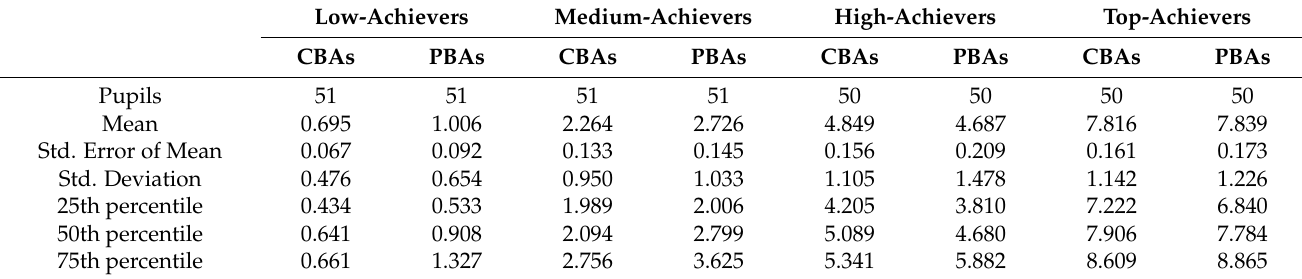
Table 6. Descriptive PRSs statistics of subgroups of achievers in CBA and PBA